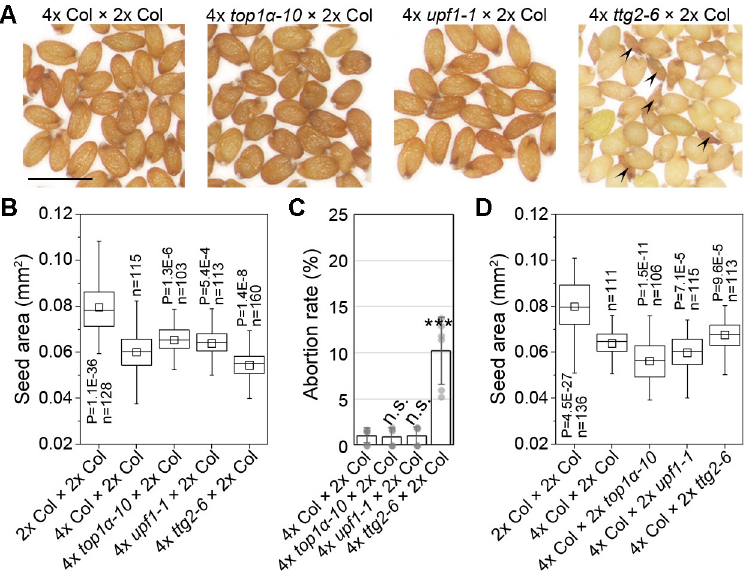
Fig 6. TOP1 α , UPF1 , and TTG2 affect the phenotypes of maternal-excess interploidy crosses. (A) Morphology of the seeds produced by 4x mutants pollinated with diploidy wild type. Arrowheads indicate the aborted seeds. Scale bar, 0.5 mm. (B) Maternal mutations affect the seed size of maternal excess. P values were determined by two-tailed Mann- Whitney U-test as compared to 4x Col × 2x Col. (C) Maternal mutations affect the abortion rate of maternal excess. Values are mean ± s.d. ��� P < 0.001 as compared to 4x Col × 2x Col, two-tailed Student’s t test. (D) Paternal mutations affect the seed size of maternal excess. P values were determined by two-tailed Mann-Whitney U-test as compared to 4x Col × 2x Col. The data underlying this figure are included in S1 Data. n, number of seeds